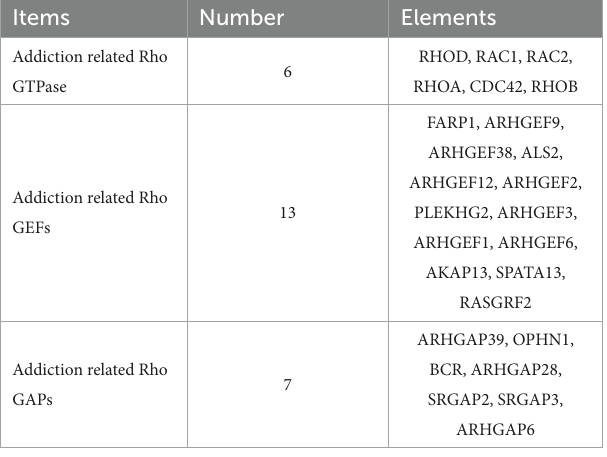
Table 1 Addiction related Rho GTPase and their